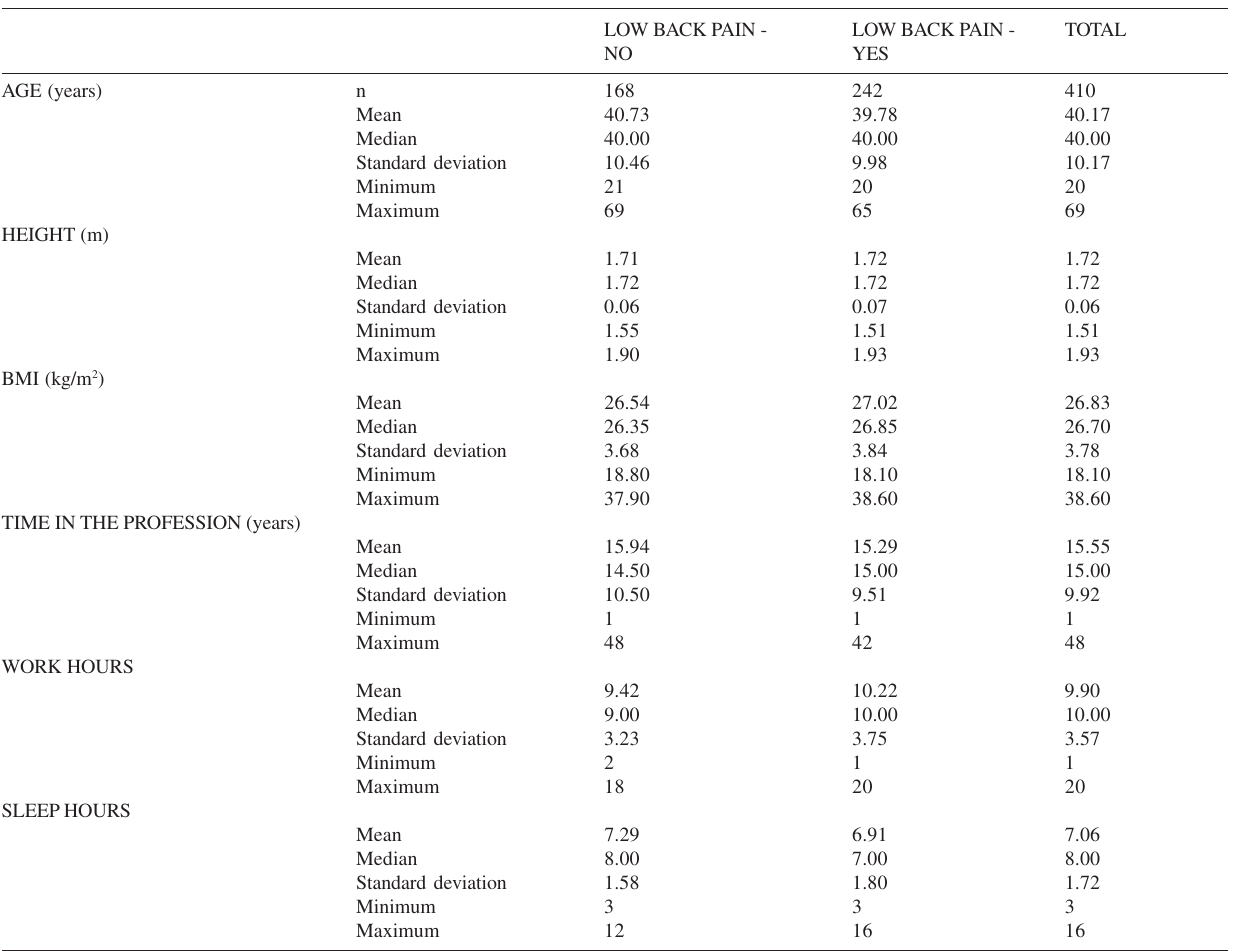
Table 2 - Mean value, median value, standard deviation, maximum and minimum values observed and sample size of the following quantitative variables: age, height, BMI value, length of time in the profession, work hours, and sleep hours, according to the Yes and No categories of low back